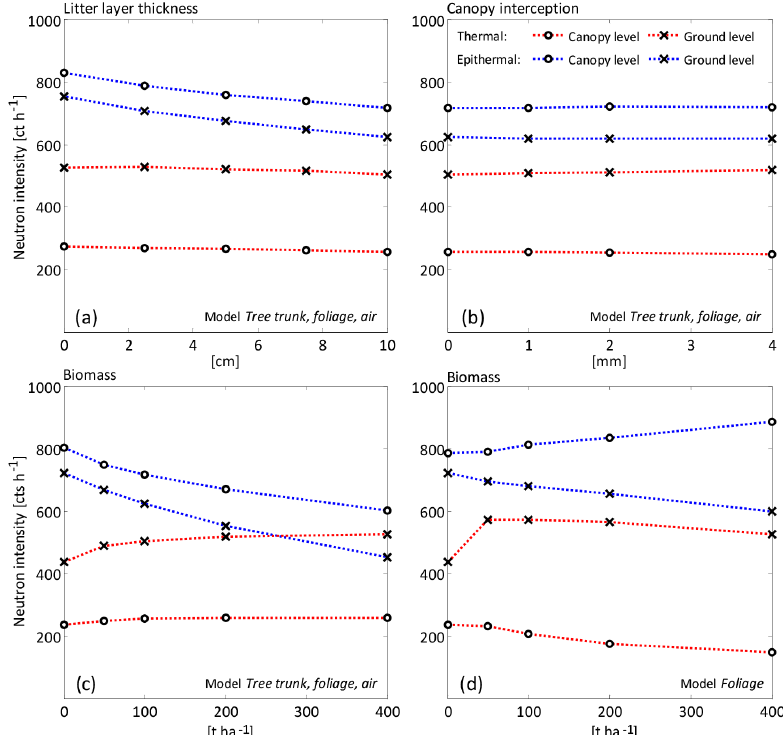
Figure 6. Sensitivity of ground- and canopy-level thermal and epithermal neutron intensity to (a) litter-layer thickness using model tree trunk, foliage, air, (b) canopy interception using model tree trunk, foliage, air and biomass using (c) model tree trunk, foliage, air and (d) model foliage,